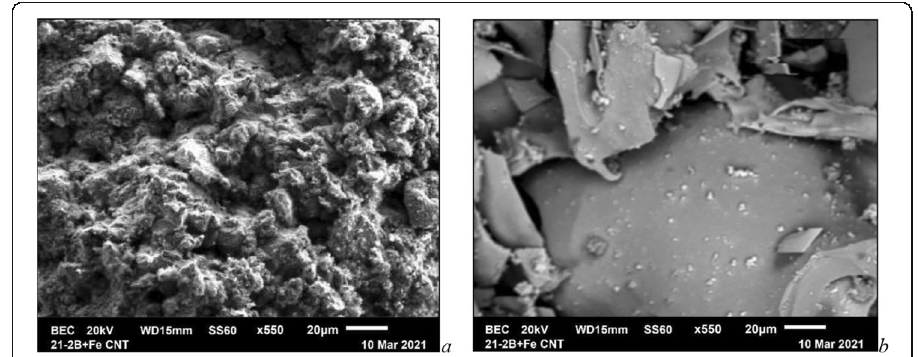
Fig. 4 Typical microrelief of granules surfaces obtained by hydro-channel granulation of GPIS (grain size 2 mm) ( a ); the same in hydro-vacuum granulation (grain size 0.2 mm) ( b